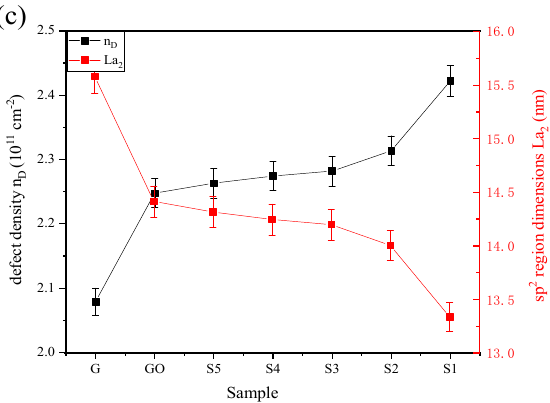
Figure 9. Raman spectra of ( a ) S1, GO and G. ( b ) S1, S2, S3, S4 and S5. ( c ) Defect density of all samples.